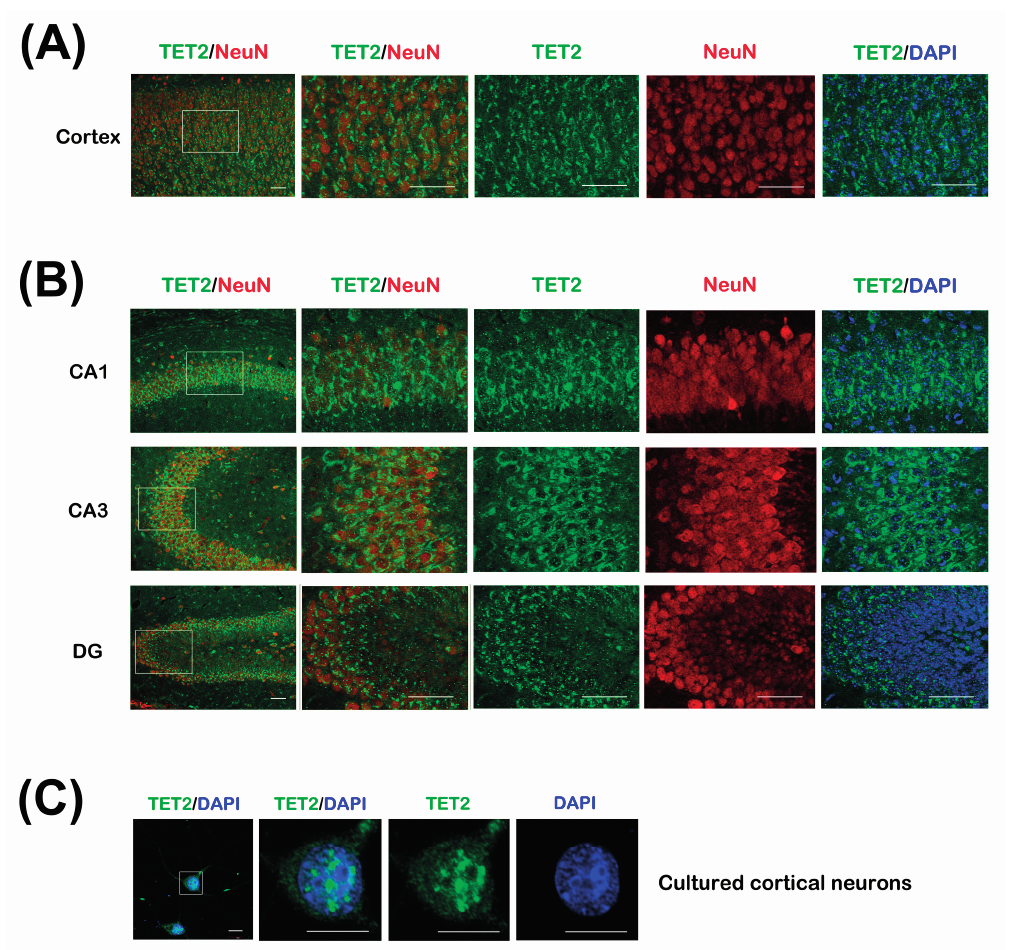
Figure 2. ( A ) The cerebral cortex sections of 8-week mice were co-stained with TET2 and NeuN antibodies, DAPI was stained for nuclear. The white rectangle region of upper cortex in the left image was magnified and showed on the right four panels. Bar = 50 μ m; ( B ) CA1, CA3, and dentate gyrus (DG) regions of hippocampus sections were co-stained as in ( A ). Bar = 50 μ m; ( C ) Primary cortical neurons at 3 days in vitro (DIV) were stained with TET2 antibody and DAPI. The neuron in the white rectangle region of the left image was magnified and showed on the right panels. Bar = 10 μ